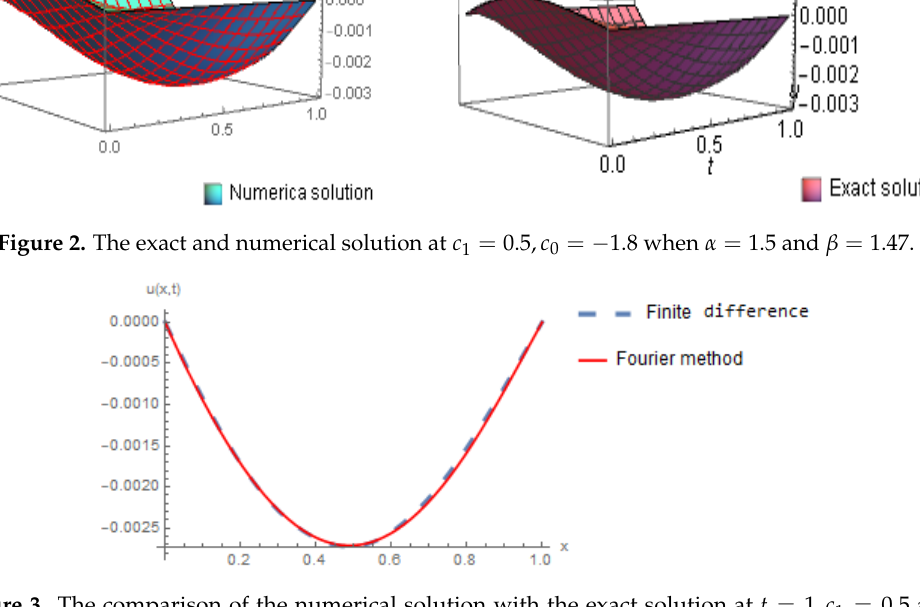
Figure 3. The comparison of the numerical solution with the exact solution at t = 1, c 1 = 0.5 and c 0 = − 1.8 when α = 1.5 and β =